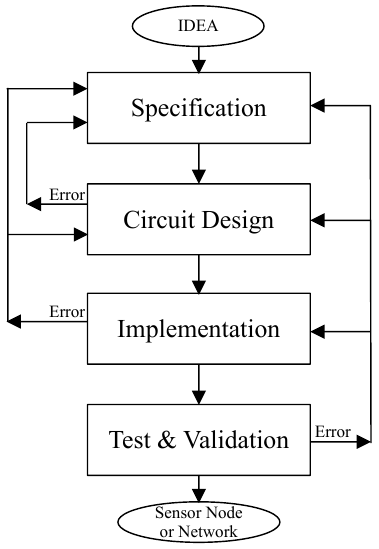
Figure 1. Traditional electronic design flow methodology